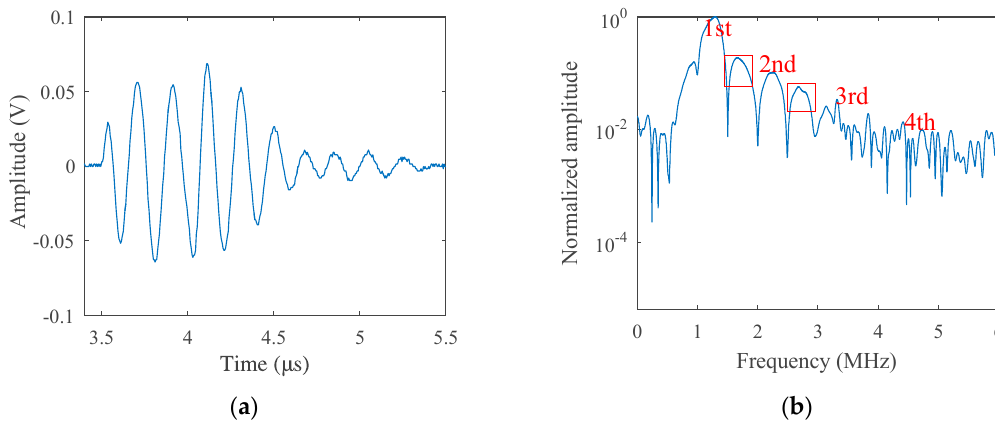
Figure 9. ( a ) Transmitted signals received from the fatigue sample (Loading Cycle 20,000) in the time-domain and ( b ) in the frequency-domain (excitation voltage 200 V).